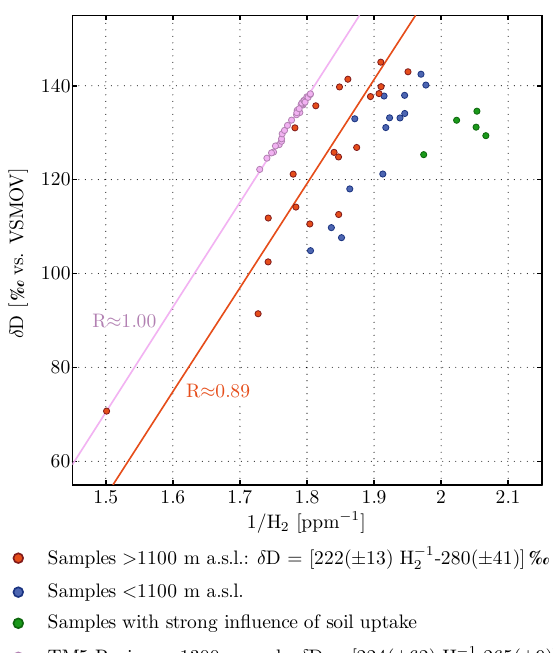
Fig. 3. Keeling plot showing δ D versus the inverse mixing ratio of H 2 . The same colour scheme as in Fig. 2 is used to classify the BARCA-A samples. The Keeling plot returns an y -axis intercept of − 280 ± 41‰ as isotopic signature of the contaminating source. The regression line (red) is derived with a bivariate total least square fitting technique. Pearson’s correlation coefficient for all samples above 1100ma.s.l. yields a value of − 0.89 and is significant at a 99% confidence level. The pink points that show TM5 results at about 1300ma.s.l. are from Fig. 4. Regression analysis for these points results in a δ D bb signature of − 265‰ which is close to the model input value at the surface of −